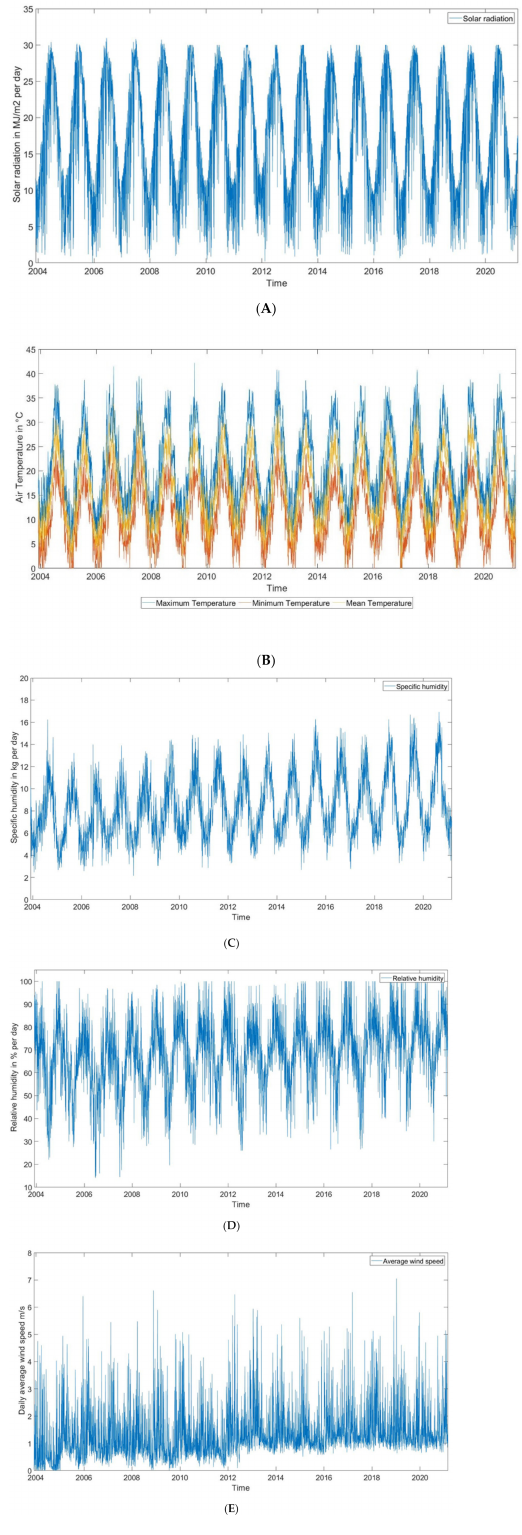
Figure 4. Daily timeseries of climate variables from December 1, 2003–December 28, 2021: ( A – E ) are Solar radiation, Air temperature (maximum, minimum, and mean temperature), Relative humidity, Specific humidity, and Wind speed,